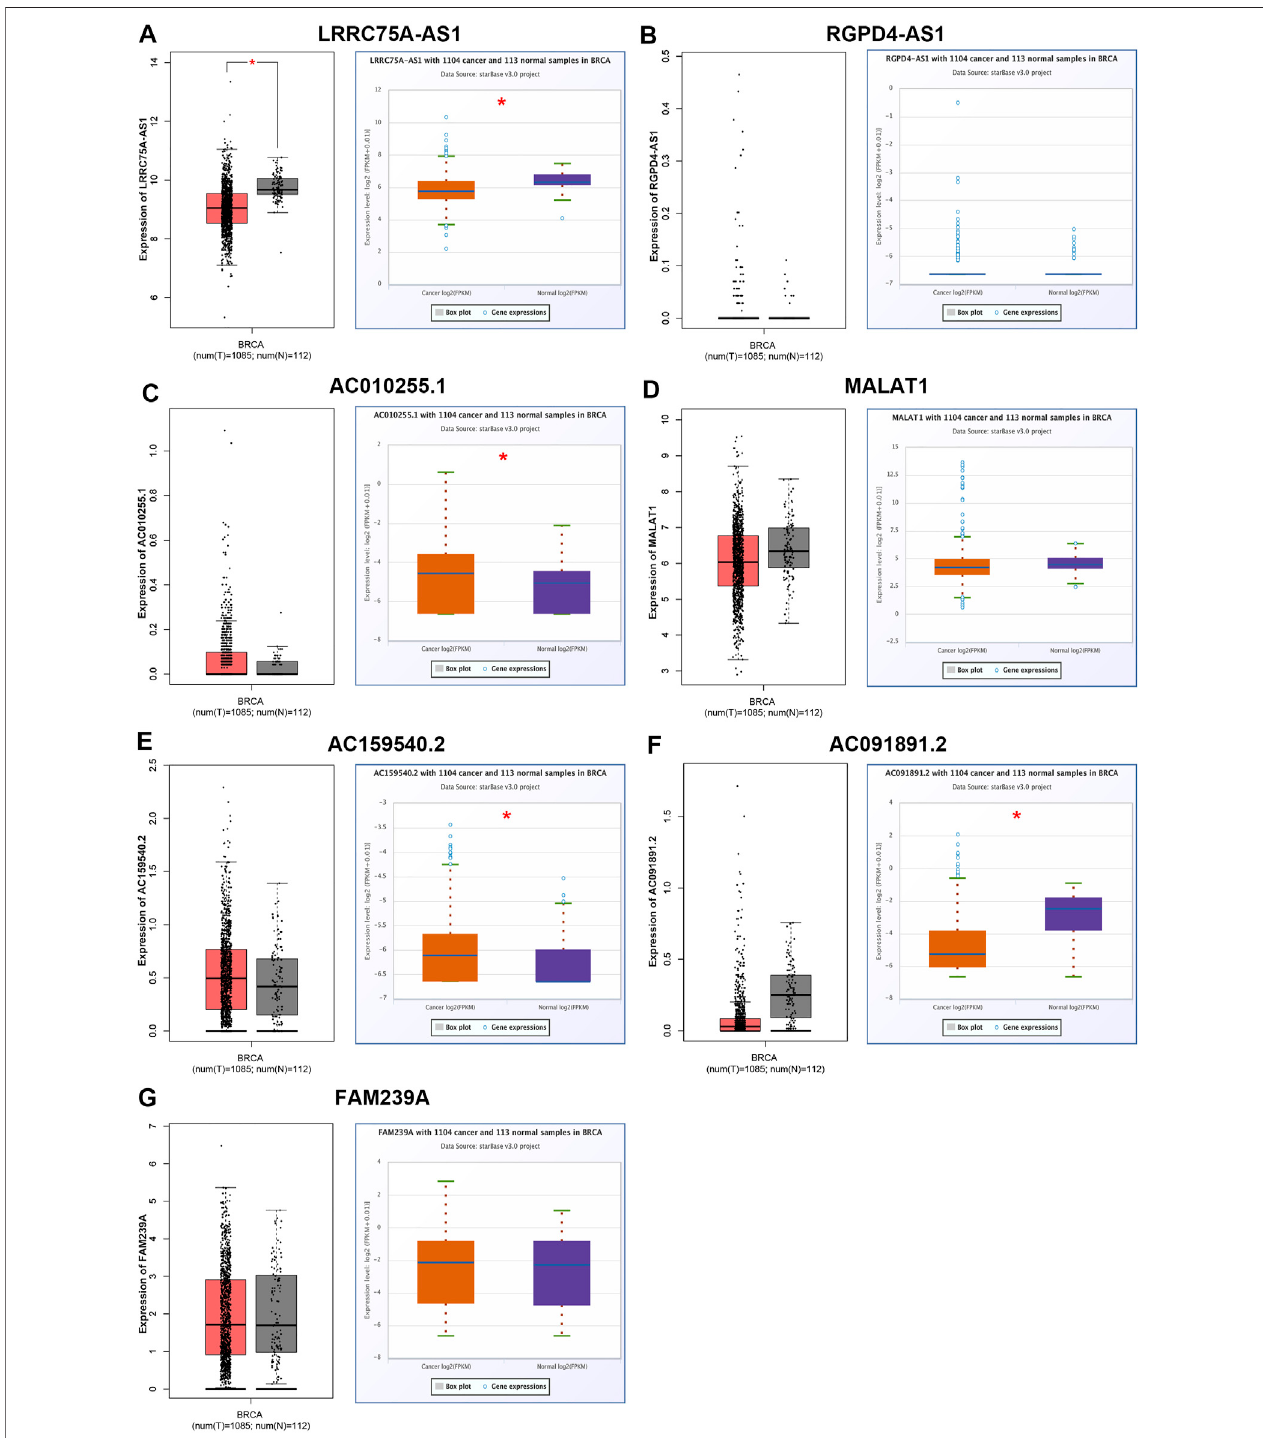
FIGURE 1 | Identi fi cation and validation of potential in fl ammation-related lncRNAs in breast cancer. The expression of LRRC75A-AS1 (A) , RGPD4-AS1 (B) , AC010255.1 (C) , MALAT1 (D) , AC159540.2 (E) , AC091891.2 (F) and FAM239A (G) in breast cancer compared with normal controls determined by GEPIA and starBase databases. * p < 0.05.